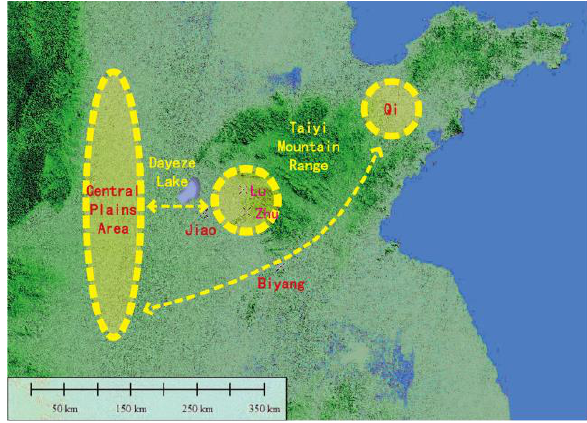
Figure 22. The situation analysis of Biyang and Jiao Overall, survey region situated between Dayeze Lake and Taiyi mountains, relatively independent. However, Biyang and Jiao were both small country and located on the traffic arteries linked to the surrounding countries. Traditionally, regions like this generally had territorial divisions, and small countries there couldn't get rid of the fate of perishing. The fate of the two countries reflected the unrest of the geographical unit transfer parts was portrayal of the change in national strength contrast. Nowadays, Jiao is close to the border of Jining and Heze; Biyang is located in the southern tip of Zaozhuang, close to Shandong and Jiangsu border, both are still at the boundary of administrative divisions.